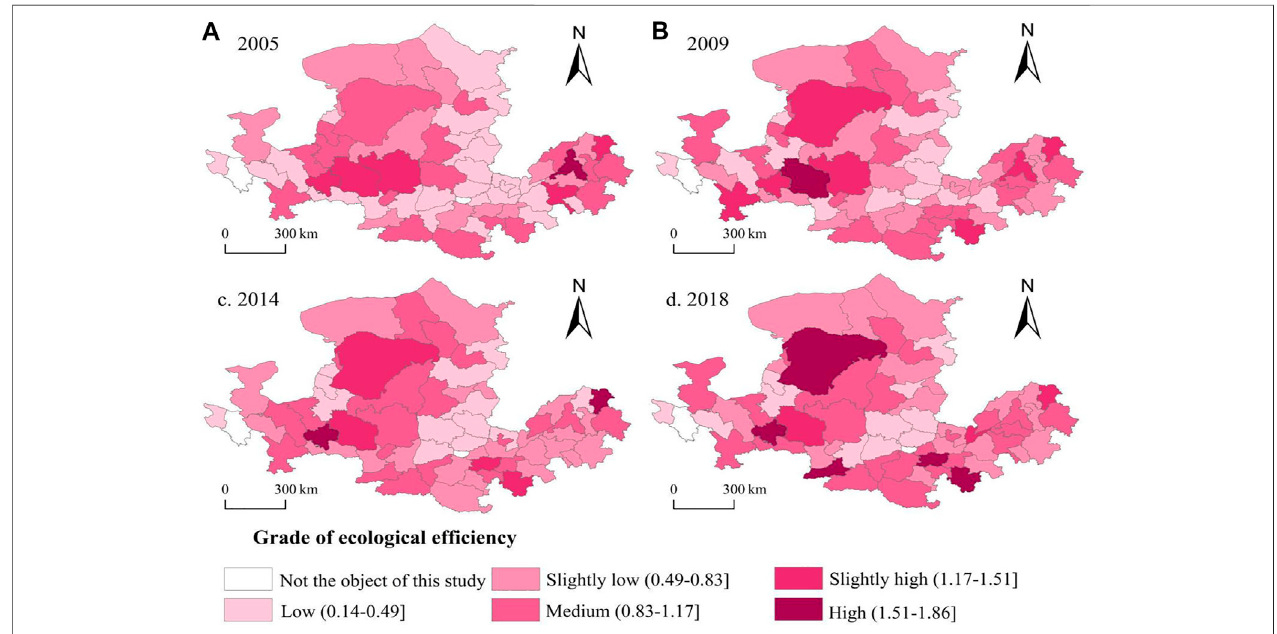
FIGURE 2 | Spatial distribution trends of ecological ef fi ciency in the Yellow River Basin from 2005 to 2018. (A) 2005, (B) 2009, (C) 2014, and (D) 2018.